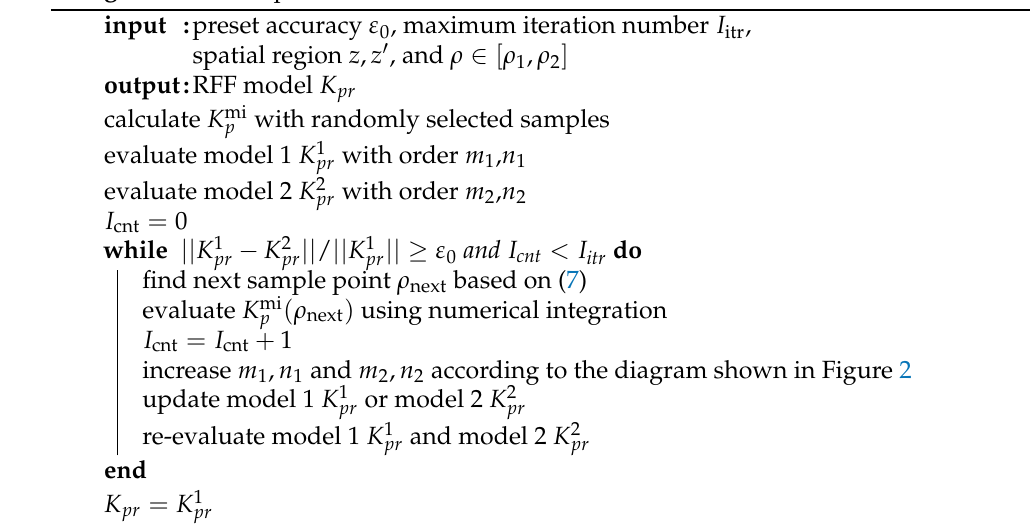
Algorithm 1: Adaptive RFF for